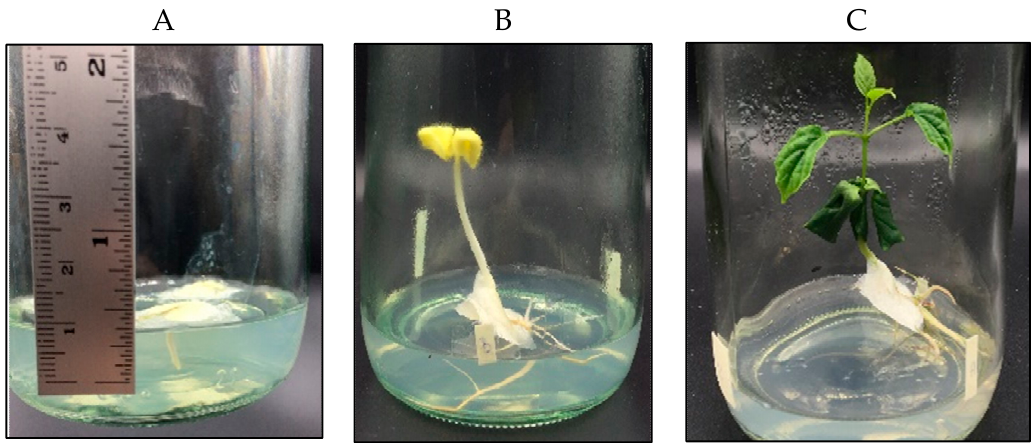
Figure 2. Physical characteristics of Oroxylum indicum tissue-cultured plant samples; A = day 4, B = week 3, C = week 9.